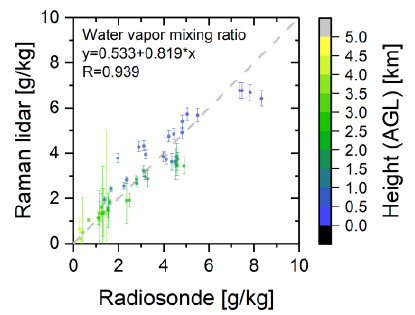
Figure 2 regression of water vapor mixing ratio profile to radiosonde measurement